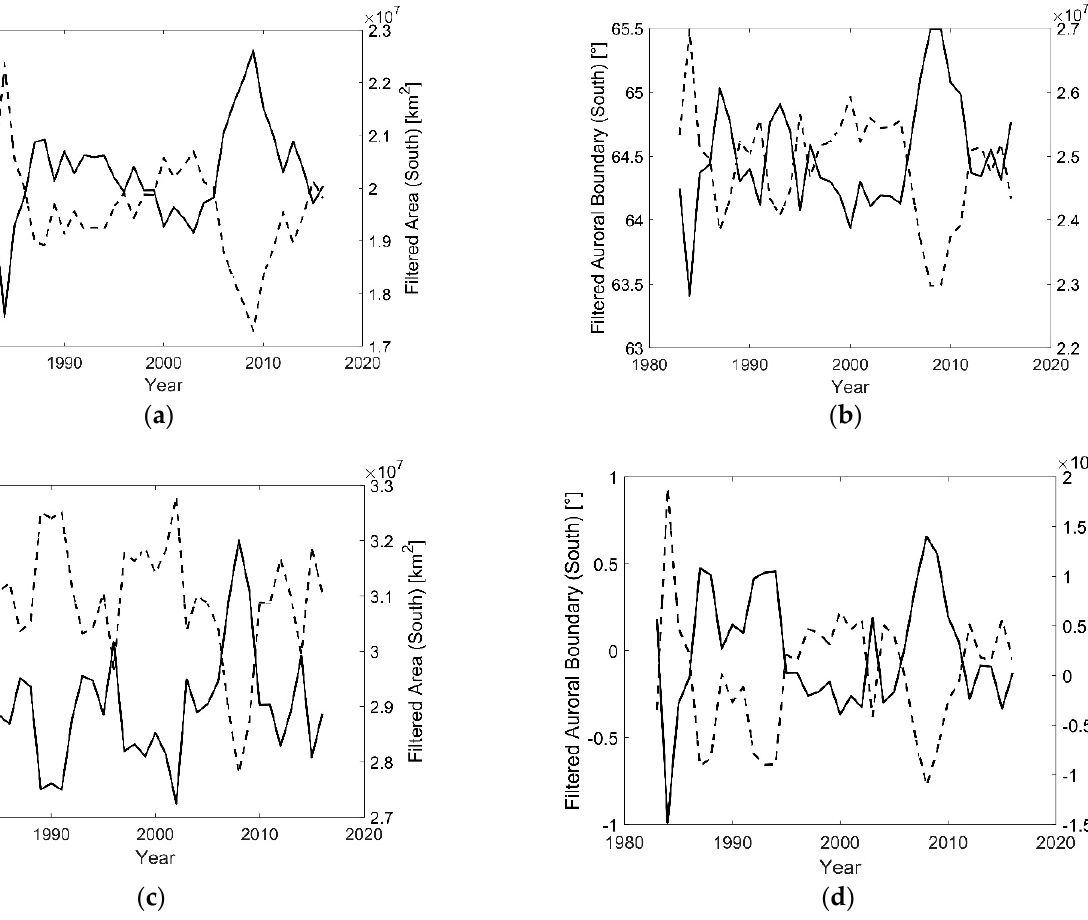
Figure 6. As in Figure 5 for the Southern hemisphere.